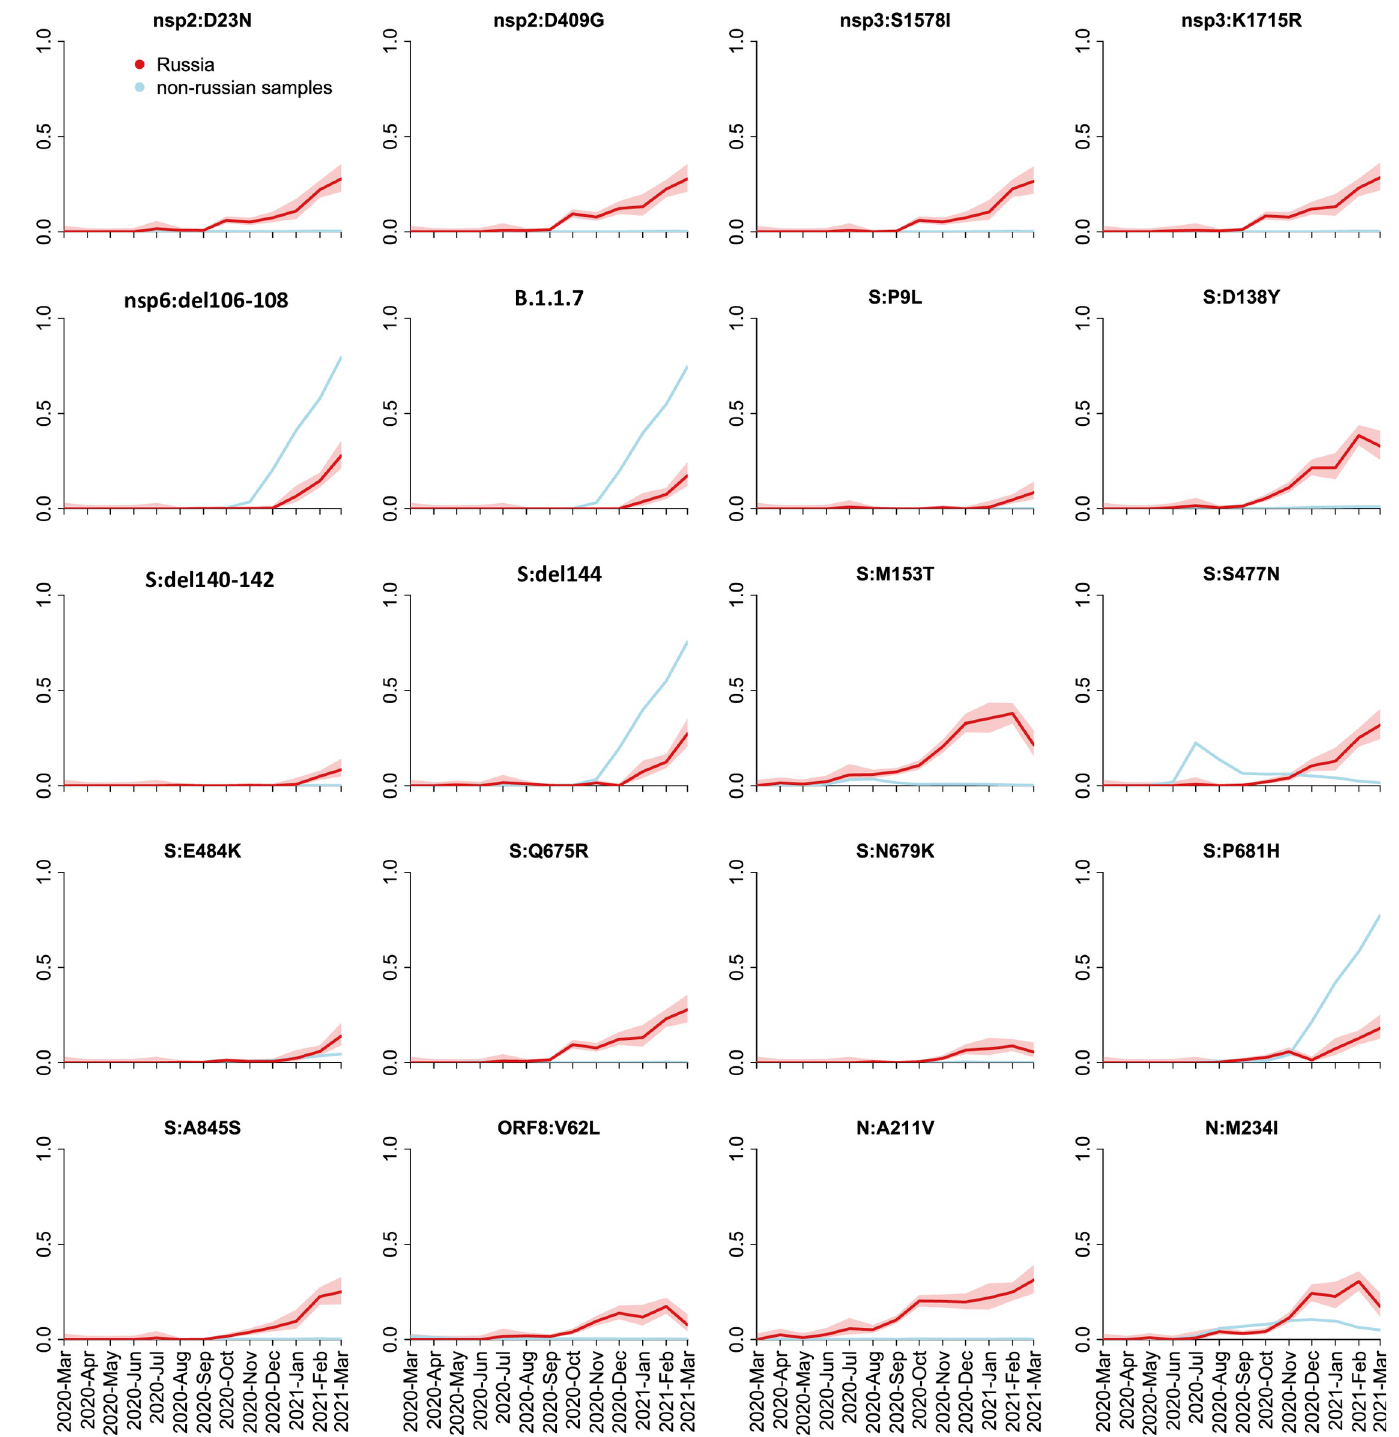
Fig 3. Frequency dynamics of SARS-CoV-2 amino acid changes. Plots represent changes in frequency over time for the non-reference amino acid mutations that reached frequencies above 10% (5% for the S protein) among the 461 Russian samples obtained in February-March 2021. The frequency of B.1.1.7 is represented by the mutation nsp3:I1412T; deletions nsp6: Δ 106–108 and S: Δ 144 and substitution S:P681H which are a part of B.1.1.7 as well as other lineages are shown separately; the remaining 14 mutations such that > 70% of samples carrying them belonged to B.1.1.7 are not shown. Changes in frequency in Russian (red) and non-Russian (blue) samples are shown in one-month time intervals. Shaded areas show 95% confidence intervals (Wilson score intervals).